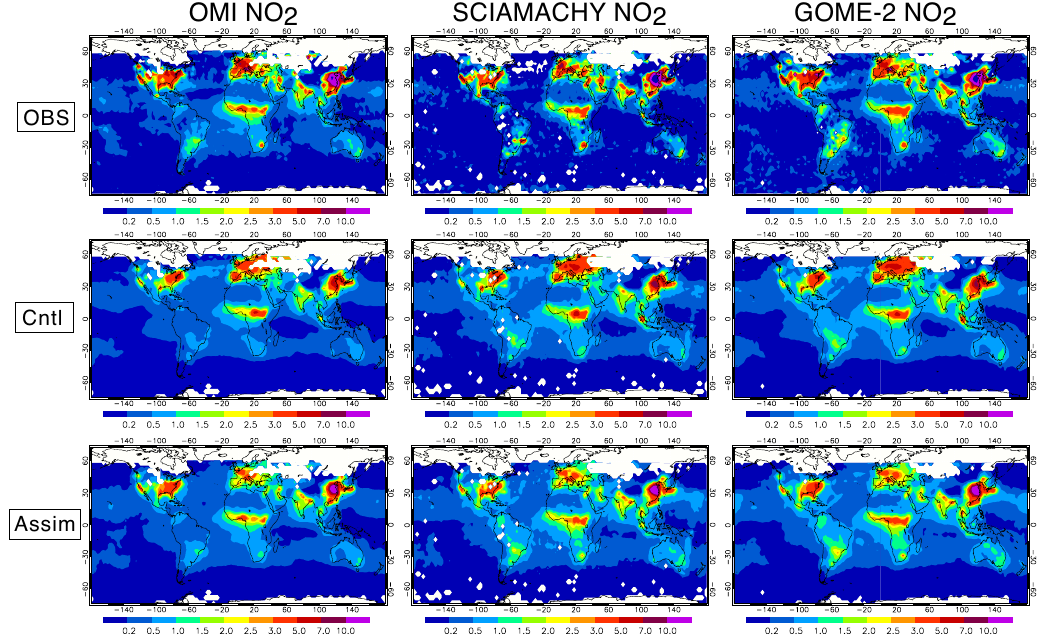
Fig. 8. Global distributions of the tropospheric NO 2 columns (in 10 15 moleccm − 2 ), averaged over the period 16–30 January 2007. The results are shown for OMI (left columns), SCIAMACHY (middle columns), and GOME-2 (right columns). Upper rows show the tropospheric NO 2 columns obtained from the satellite retrievals (OBS); centre rows from the control run (Cntl); and lower rows from the data assimilation run (Assim). The averaging kernel of each retrieval is applied to the control run and data assimilation fields. The red (blue) colour indicates relatively high (low)